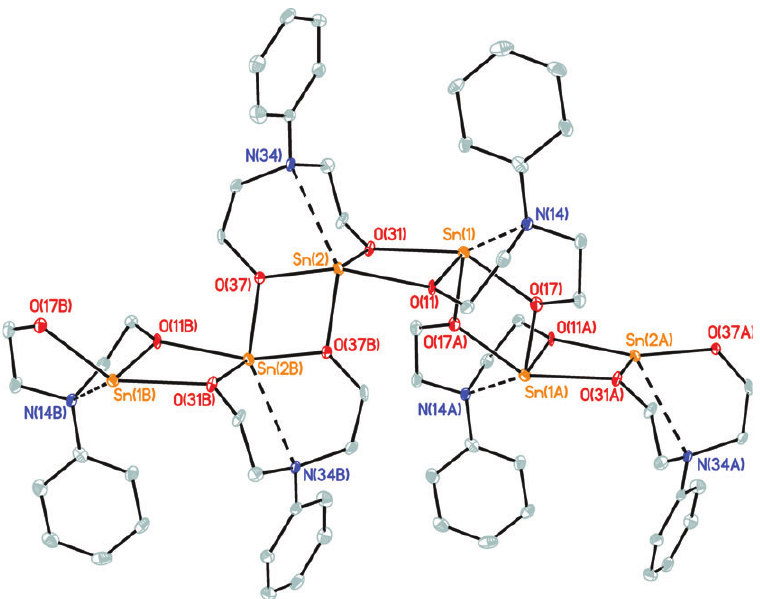
Figure 1 Polymeric structure of compound 3 ( ORTEP presentation at 30% probability of the depicted atoms and atom numbering scheme). Hydrogen atoms are omitted for